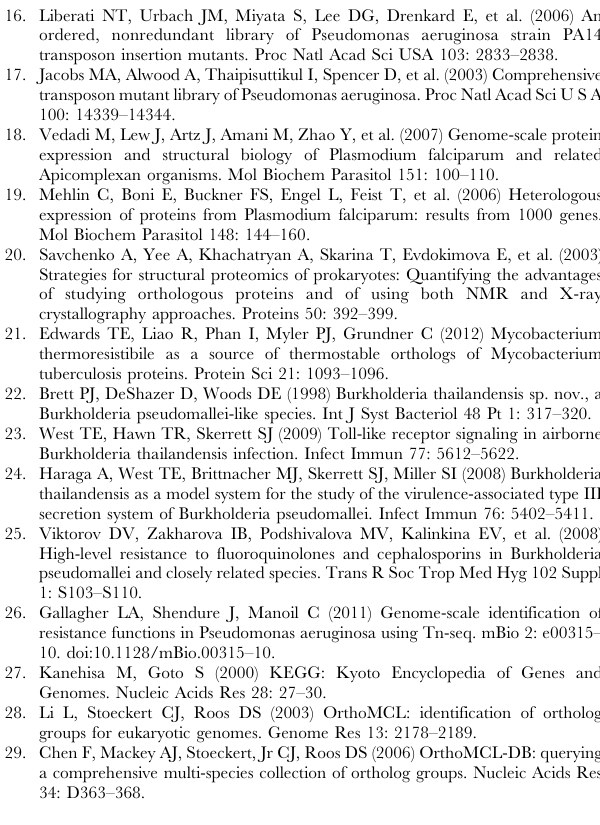
Table S4 Comparison of ortholog